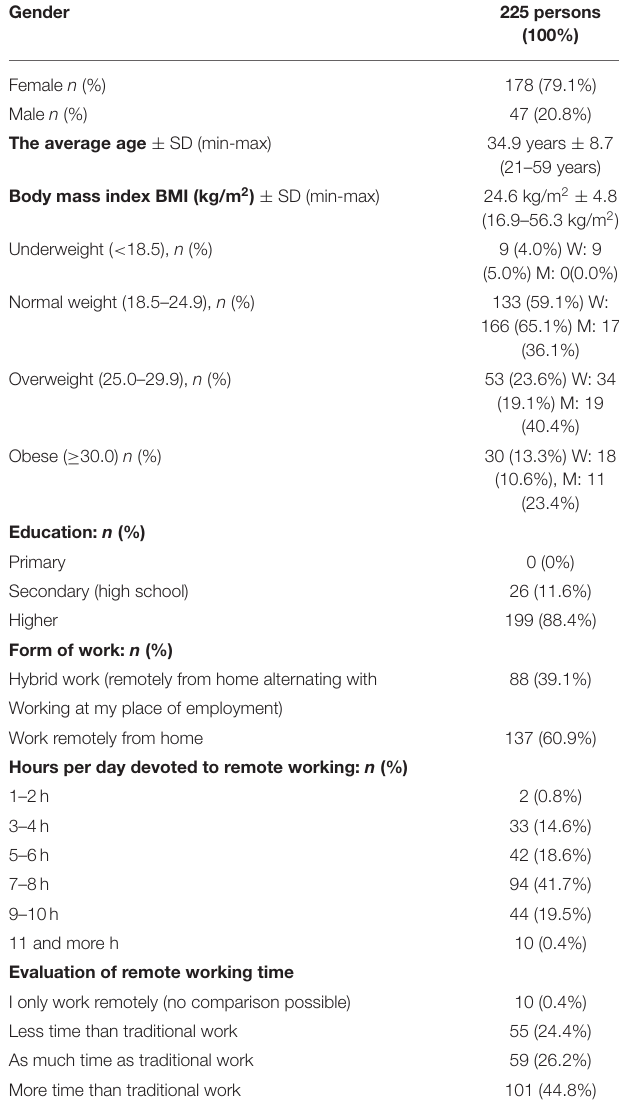
TABLE 1 | Study group by sex, age, weight, education, and form of work ( n =